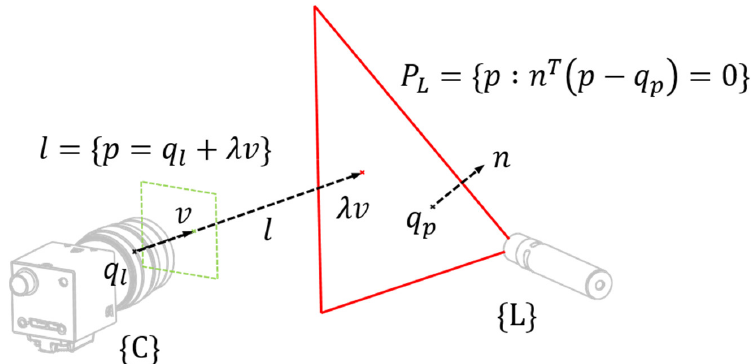
Figure 5. Line-Plane intersection.